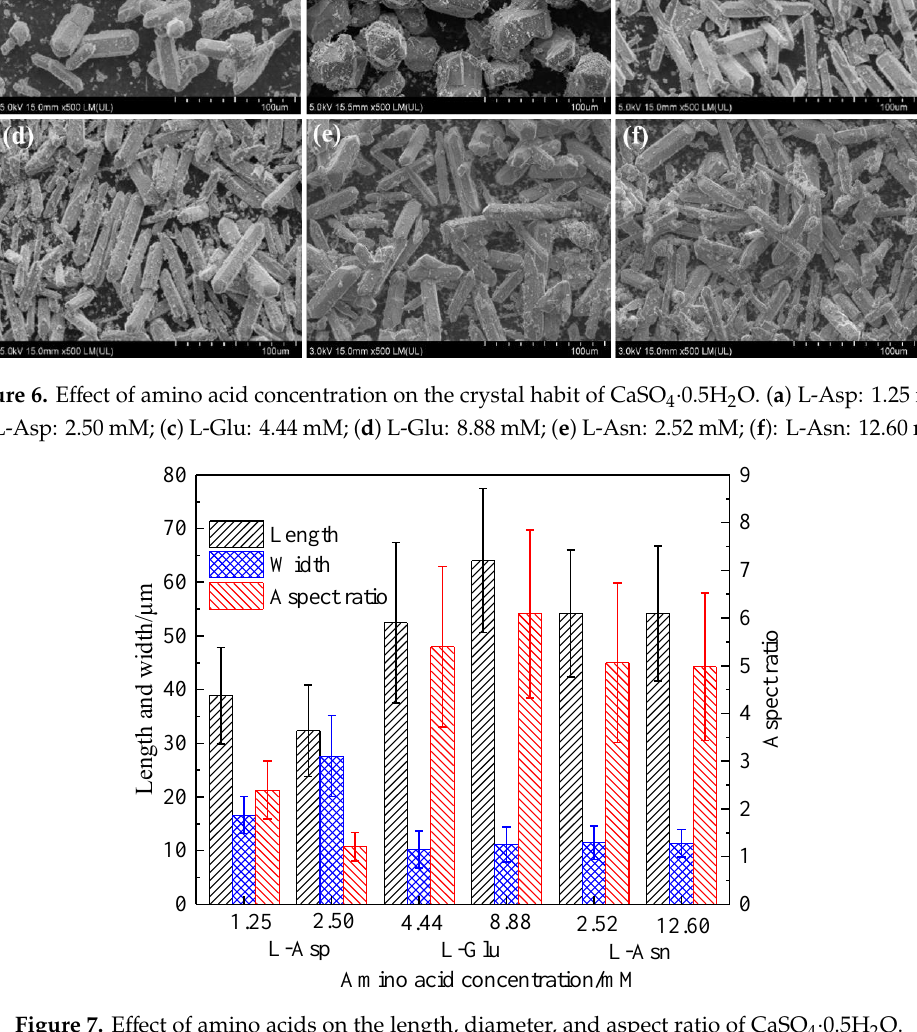
Figure 7. E ff ect of amino acids on the length, diameter, and aspect ratio of CaSO 4 · 0.5H 2